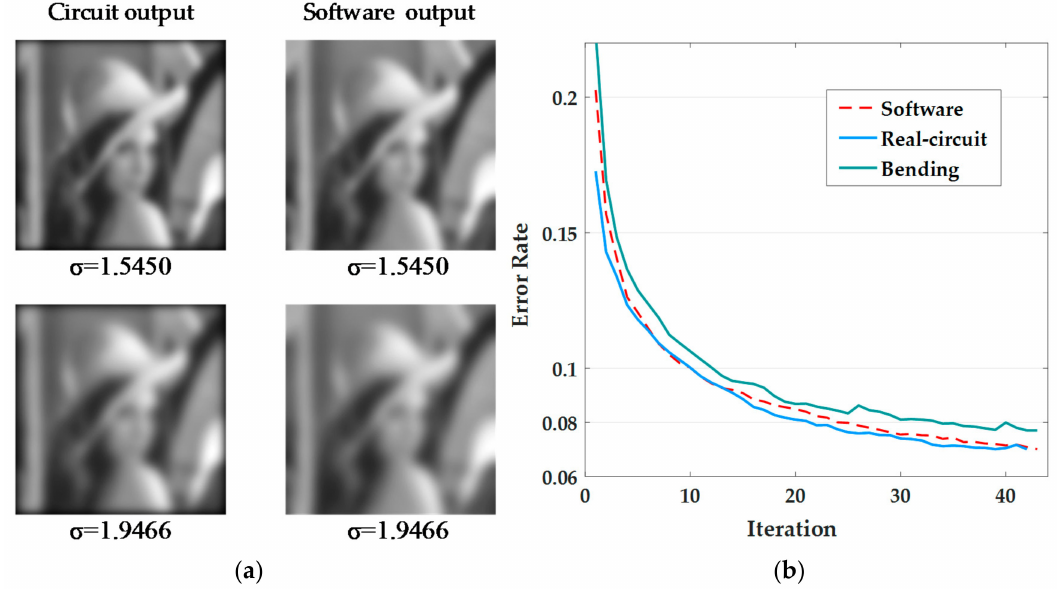
Figure 8. ( a ) Comparison of flexible computing circuit and software outputs of implementing convolution algorithm; ( b ) Classification error rate of